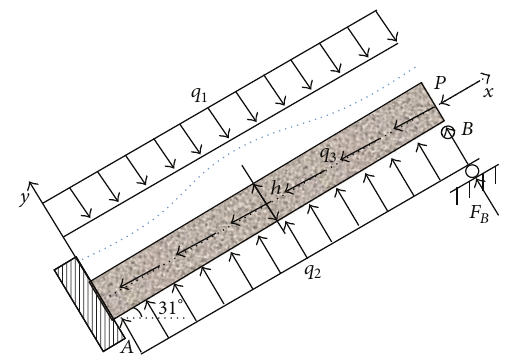
Figure 2: Mechanical model of rock burst in roadway floor caused by the instability of rock